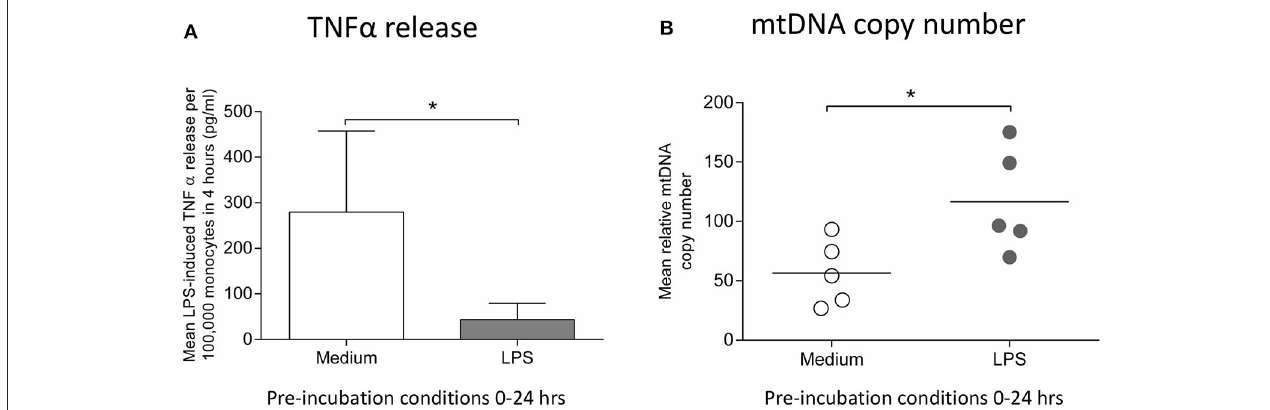
FIGURE 5 | Incubation of monocytes with LPS for 24h results in reduced ability to release TNF α in response to a second LPS stimulus and increased mtDNA copy number. Blood monocytes were incubated with LPS (10ng/ml) before measuring cytokine release and mtDNA copy number. (A) The release of TNF α in response to a second 4h exposure to LPS (10ng/ml) was measured by ELISA ( n = 5). (B) mtDNA copy number was determined by measuring MT-ND1 relative to B2M using qPCR ( n = 5). Data are represented as (A) mean ± standard deviation or (B) individual values with a line representing the mean. * p < 0.05 on independent t